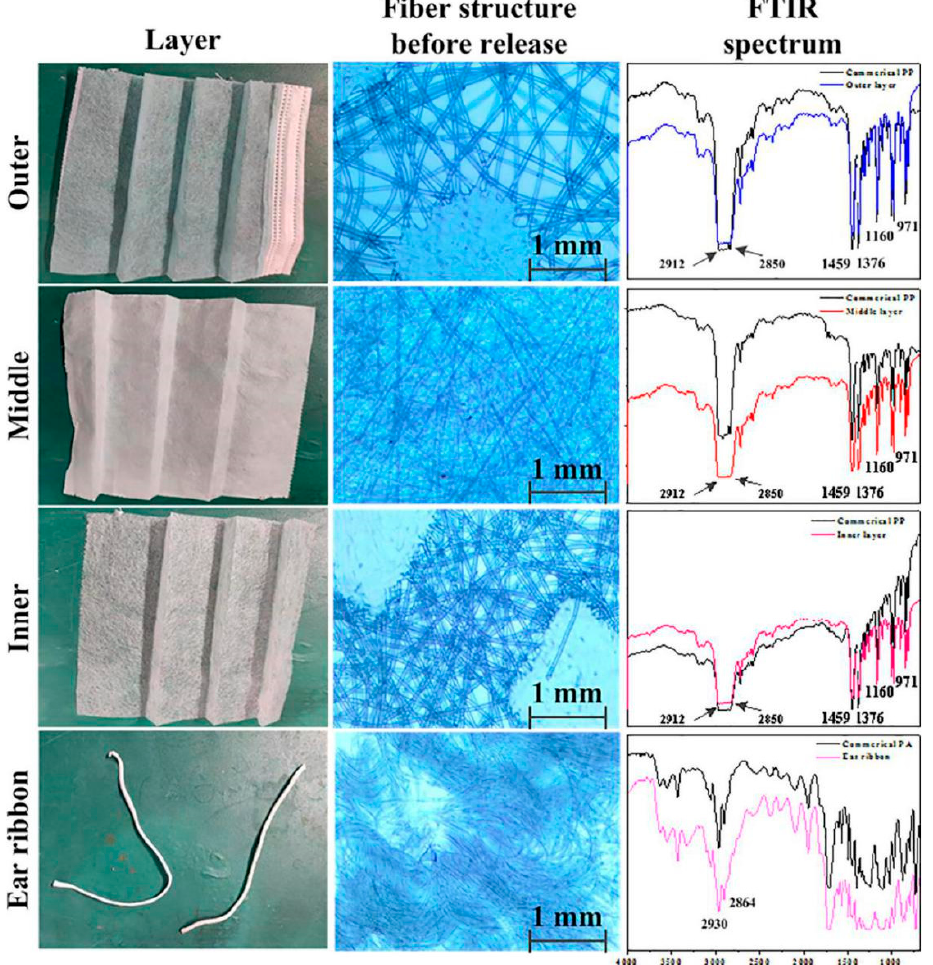
Figure 1. Structure and chemical composition of disposable surgical mask before release. Electron microscopy resolution of 3.66 µm [43].